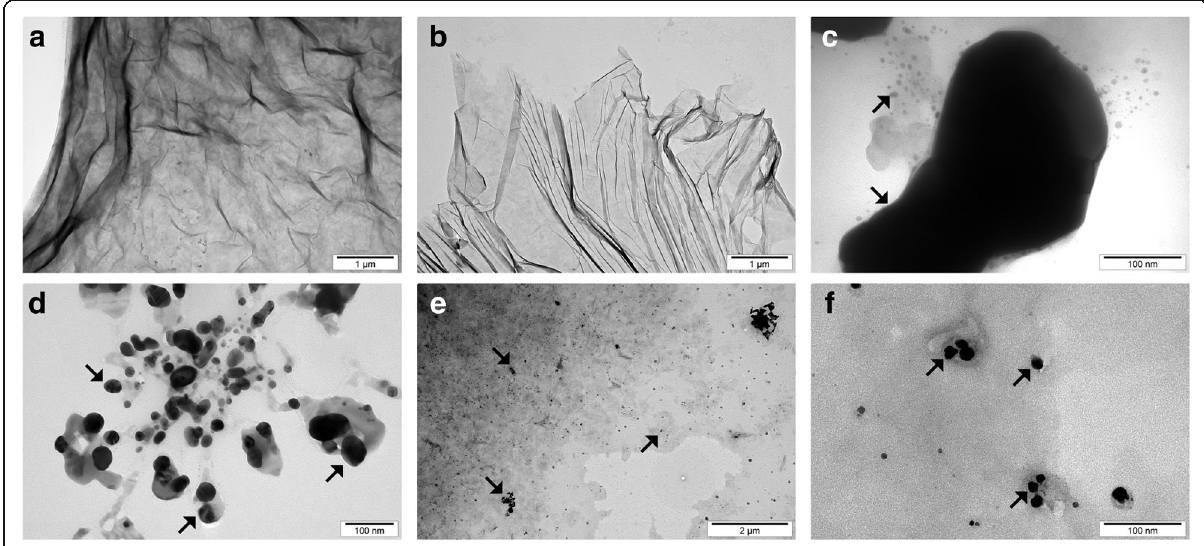
Fig. 4 TEM images of agglomerated GO flakes ( a ), GO flakes after ultrasonic treatment ( b ), agglomerated Ag-NPs ( c ), Ag-NPs after ultrasonic treatment ( d ), and GO-Ag ( e , f ). The decrease of the average GO particle size after ultrasonic treatment was caused by defragmentation or folding of the GO flakes. The decrease of the average Ag size after ultrasonic treatment was caused by defragmentation of Ag agglomerates. Note: Arrows